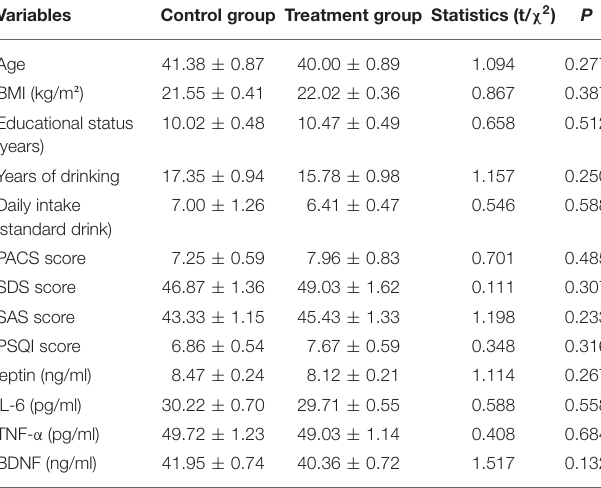
TABLE 1 | Comparison of baseline data of mean values (or ratios) of demographic data, alcohol-related data, scale scores, and plasma BDNF, IL-6, TNF- α , and leptin levels in the treatment and control groups (mean ±